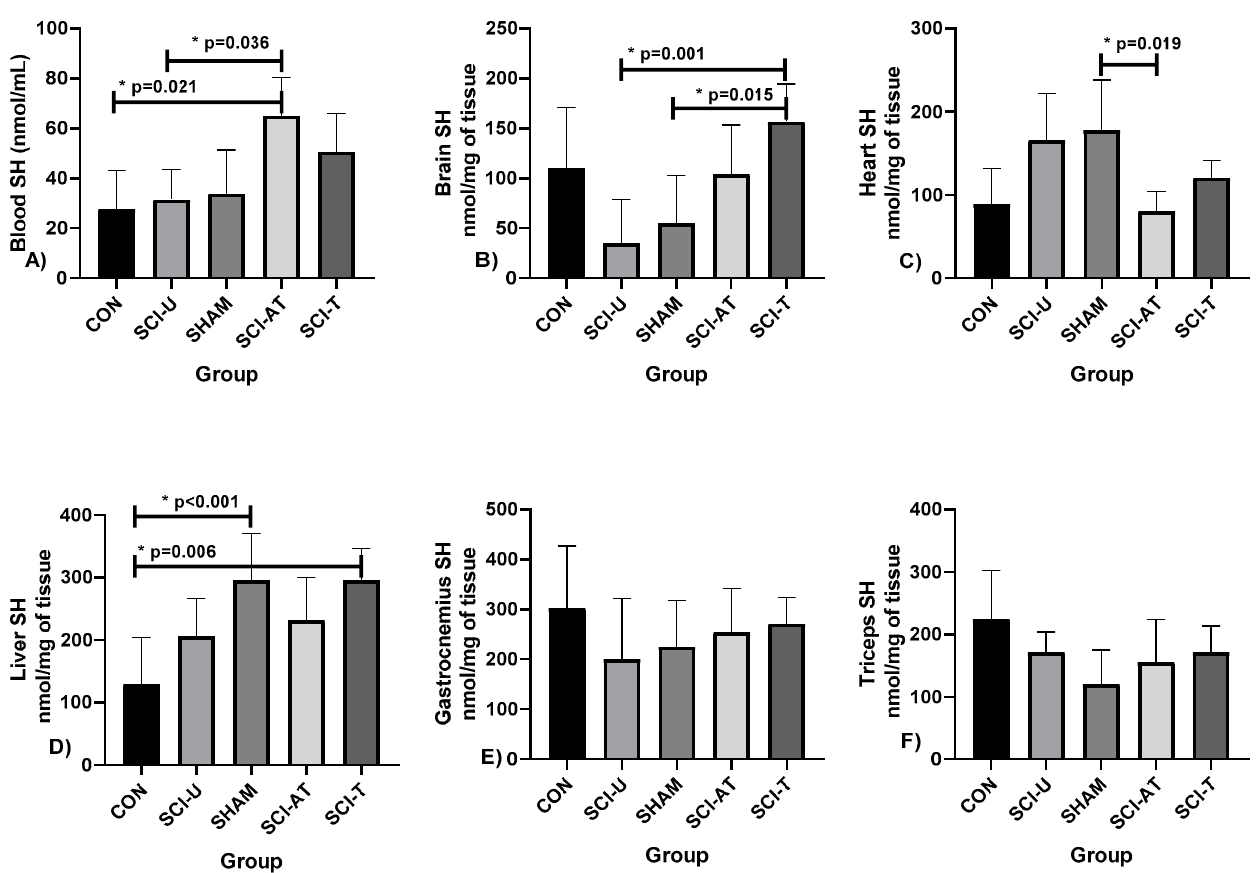
Figure 2. Oxidative Stress measured by Sulfhydryl (SH) levels measured in: ( A ) Blood, ( B ) Brain, ( C ) Heart, ( D ) Liver, ( E ) Gastrocnemius, ( F ) Triceps after interventions in the different groups: Control (CON), constituted by rats not exposed to any surgical procedure or treatment, Sham (SHAM), surgical control animals submitted to laminectomy surgery without SCI, SCI Untrained group (SCI- U), animals that underwent partial transection but were untrained, SCI Trained group (SCI- T), animals that underwent partial transection and were trained, SCI Active Trained group (SCI- AT), animals that trained previously, underwent partial transection and were trained again. * p < 0.05 ANOVA (one-way), and Bonferroni post hoc.